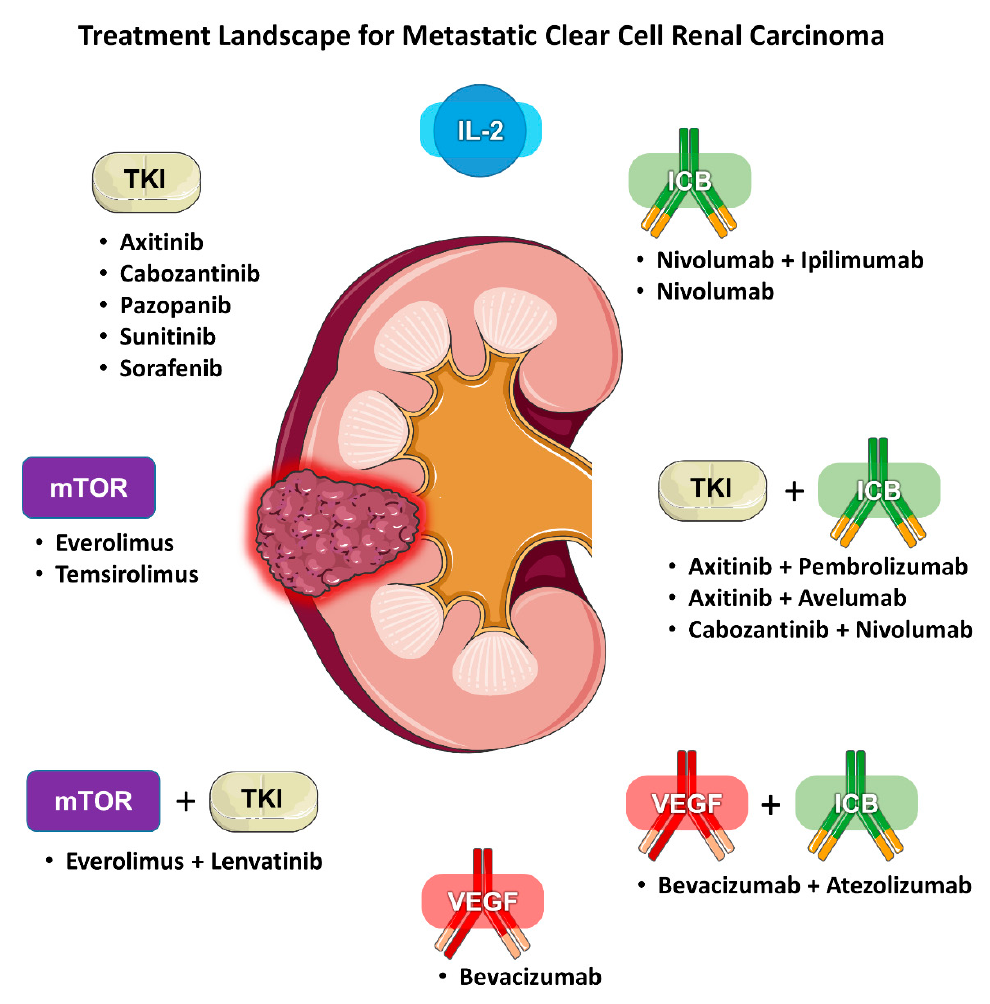
Figure 1. Treatment landscape for metastatic clear cell renal carcinoma.